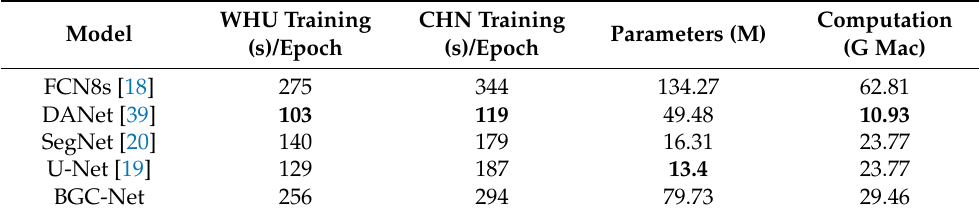
Table 7. Parameters, computation, and training time of each model in WHU dataset and CHN dataset. The best scores are highlighted in bold.